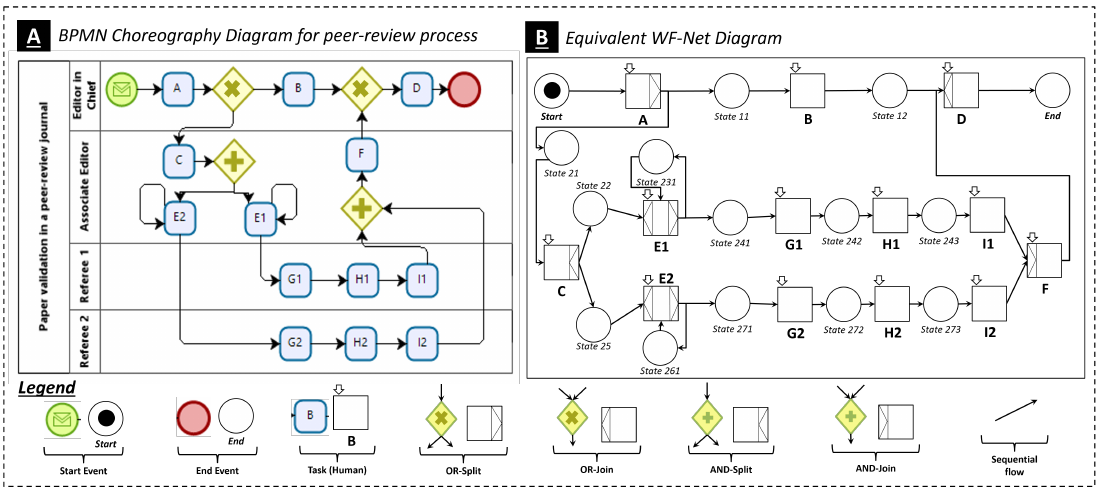
Figure 1: Orchestration diagrams of the peer-review